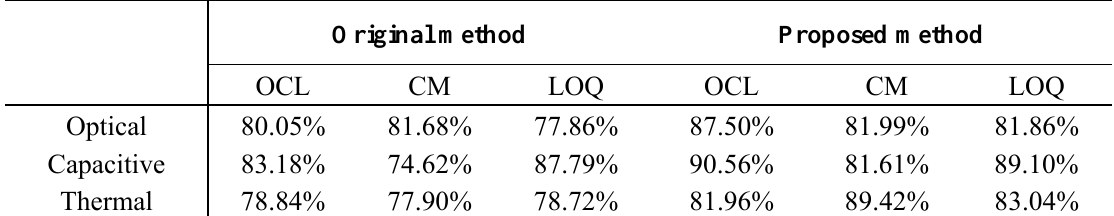
Table 4. Comparison of the classification accuracy rate when a single quality measure is used.